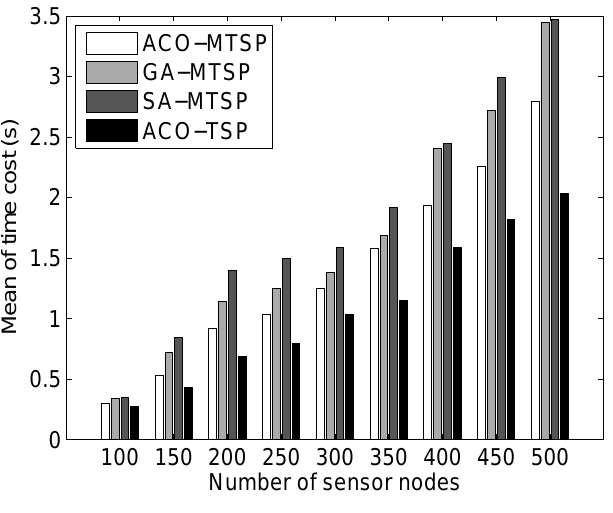
Figure 11. The mean of time cost for optimization in ACO-TSP, SA-MTSP, GA-MTSP and ACO-MTSP with the number of sensor nodes changing from 100 to 500, where the number of clusters is fixedly set to